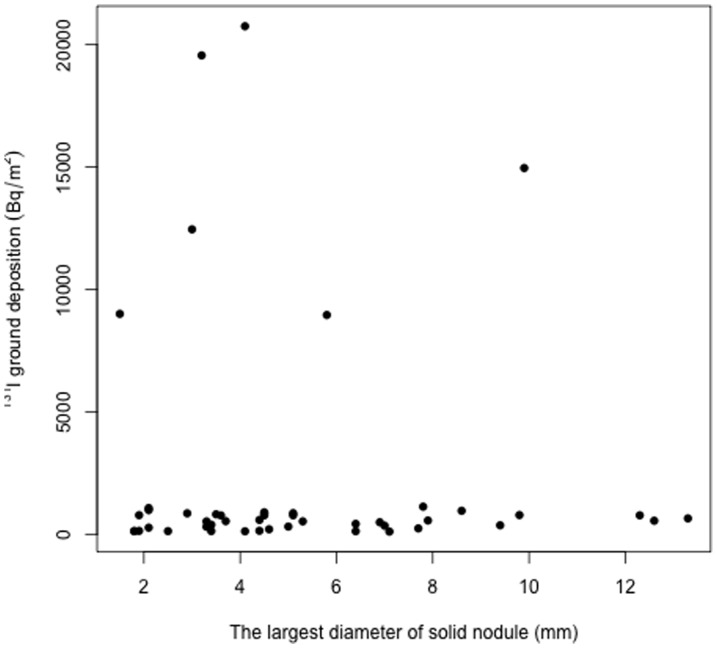
Scatter plot of the largest diameter of solid nodule vs. the 131I ground deposition in the 47 subjects who had solid nodules in the thyroid.Regression analysis revealed that there was no significant correlation between the two parameters.